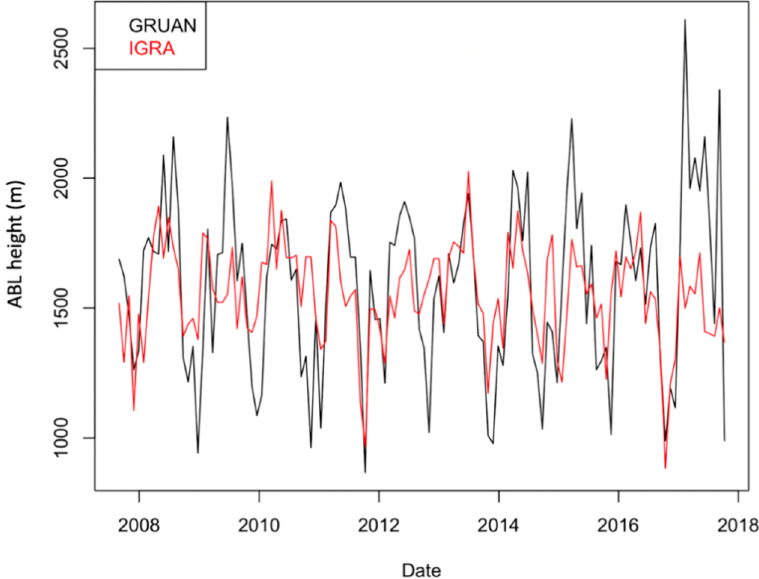
Figure 7. Atmospheric boundary layer (ABL) height retrieved using the potential temperature gradient method at the Lindenberg station, Germany (WMO index = 10,393, 52.21 N, 14.12 E, 98 m) for high-resolution radiosounding data provided by the station to the GCOS Reference Upper-Air Network (GRUAN, black line) and for low-resolution data provided to IGRA (red line). Both day and nighttime data are considered. GRUAN temperature profiles are smoothed with an effective vertical resolution [38] of 100 m and this may have a residual effect in the estimation of the BLH.